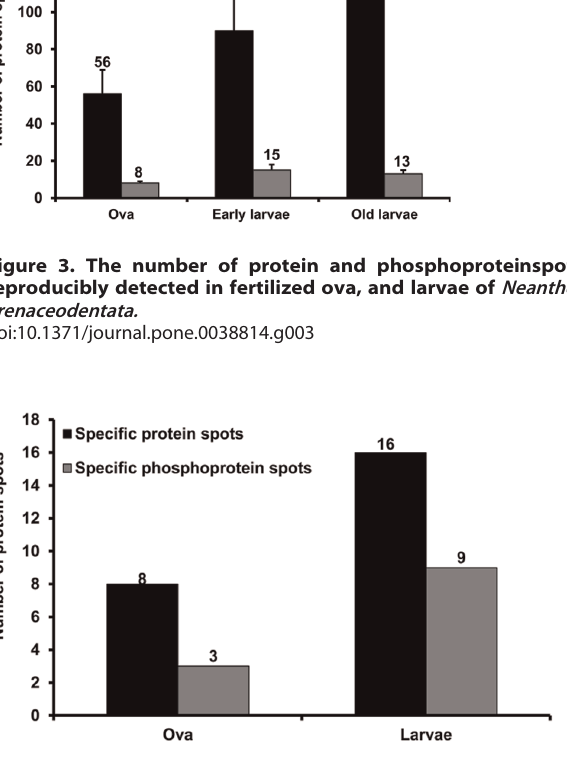
Figure 4. The number of differentially expressed abundant total protein spots and phosphoprotein spots in fertilized ova, and larvae. Differentially expressed spots showed significant differ- ences between three stages (Student’s t -test p , 0.01, n=3).